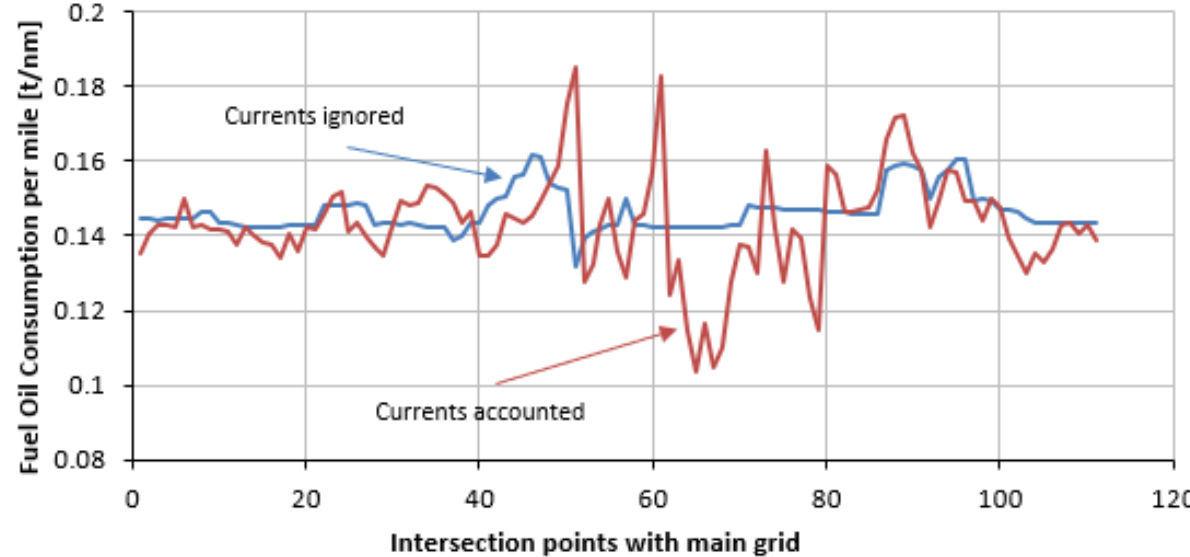
Figure 13. Fuel oil consumption per nautical mile for optimal paths found with and without the currents’ effect for clean hull conditions.